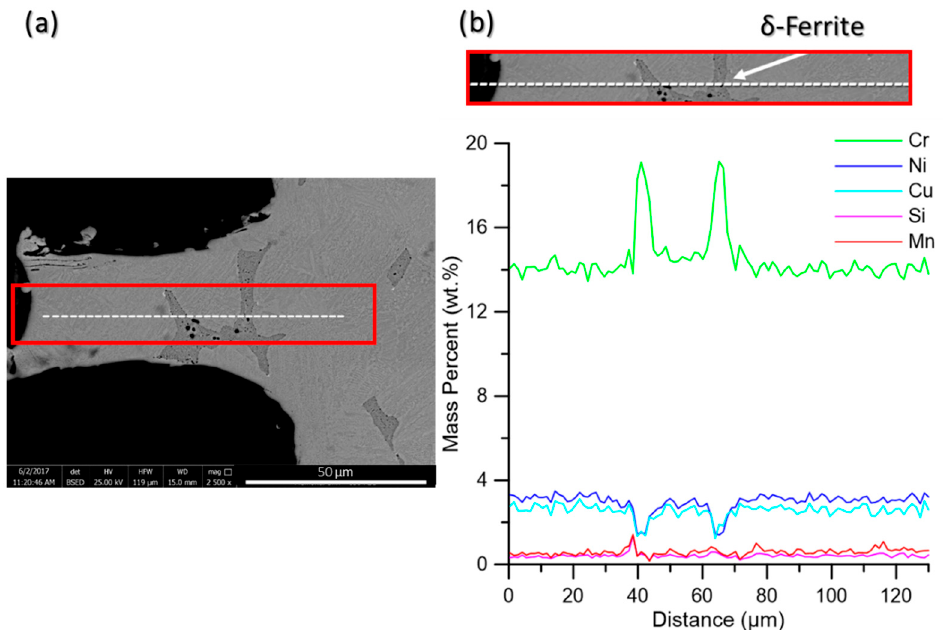
Figure 9. ( a ) SEM image taken from one surface feature of the sample with varied channeled morphology showing the position of the EDX ‐ line scan using a dashed ‐ line in the enclosed area, and ( b ) the corresponding EDX composition line scans indicating scans of Cr, Ni, Cu, Si, and Mn.